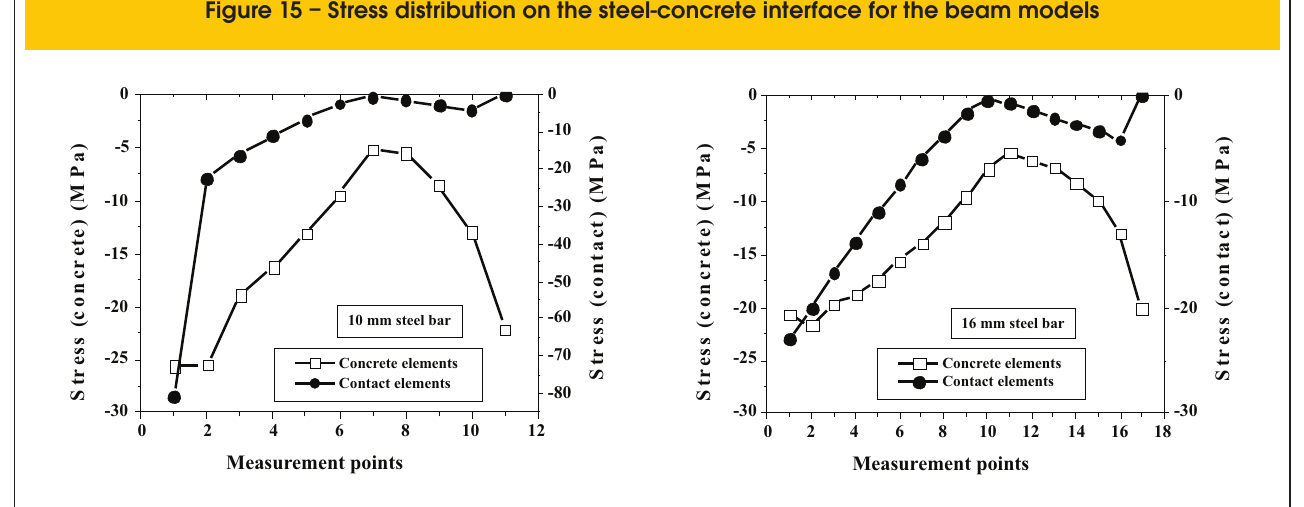
Figure 15 – Stress distribution on the steel-concrete interface for the beam